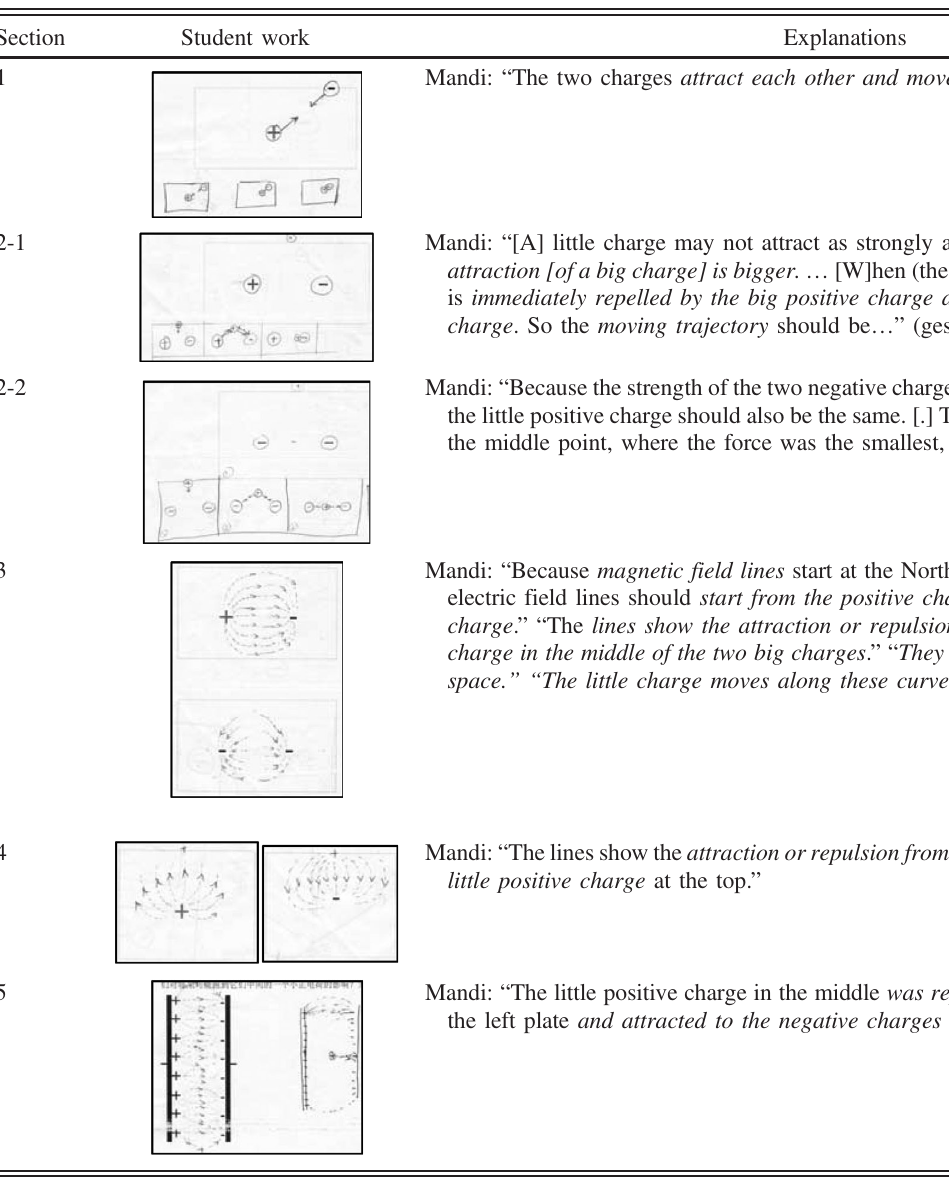
TABLE IV. Mandi ’ s work.